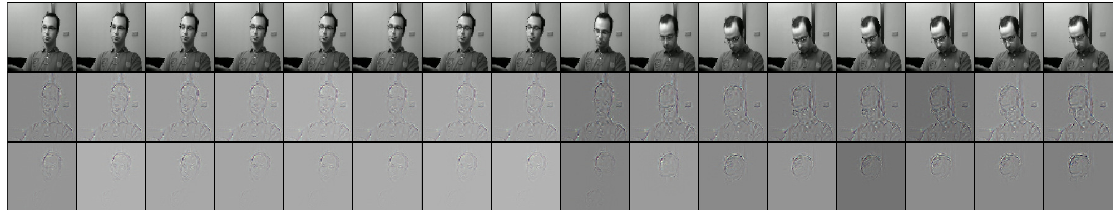
Figure 8. Application of the learned filters of the conv4b layer of our model; using the method from [64] with library tf_cnnvis [65] for extracting deconvolution images.